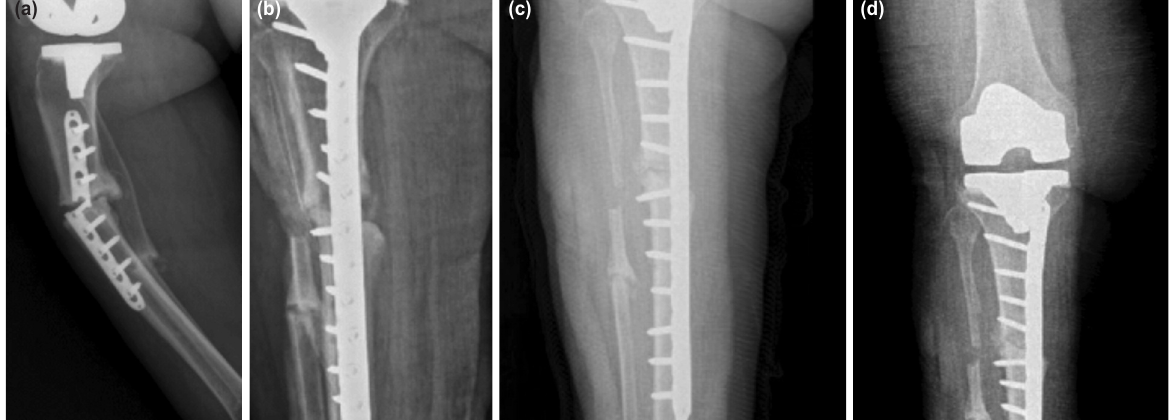
(a) Implant failure after operation for Felix type 3 periprosthetic fracture. (b) Internal fixation by means of iliacautogenous Fig. 2: grafting and locking compression plate (c) 16th week radiography. (d) 24th week